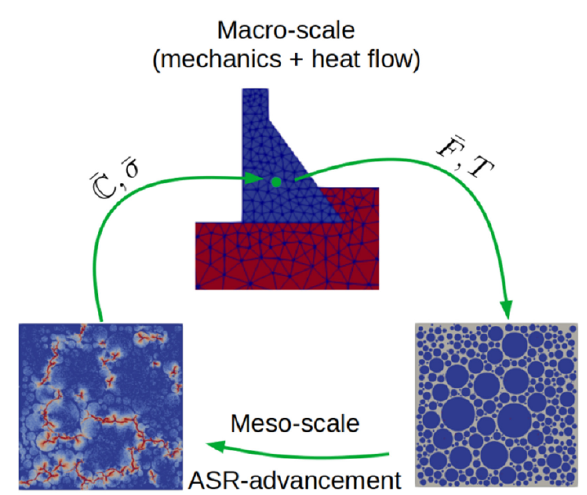
Figure 18. Schematic illustration of the multi ‐ scale scheme for ASR simulations.